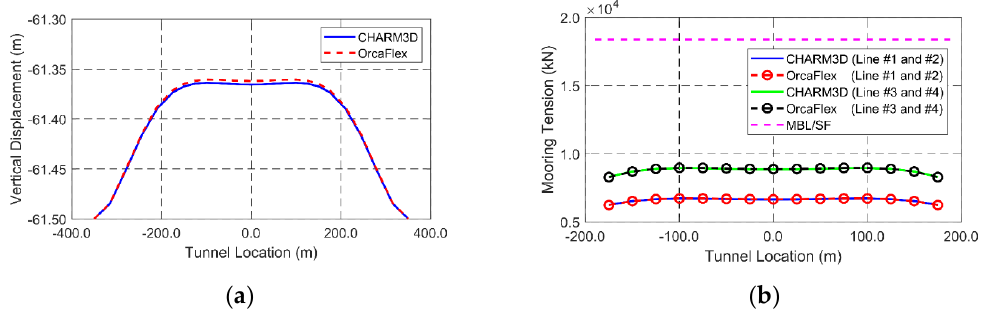
Figure 5. Submerged floating tunnel (SFT) vertical displacement ( a ) and mooring tension ( b ) in the static condition.